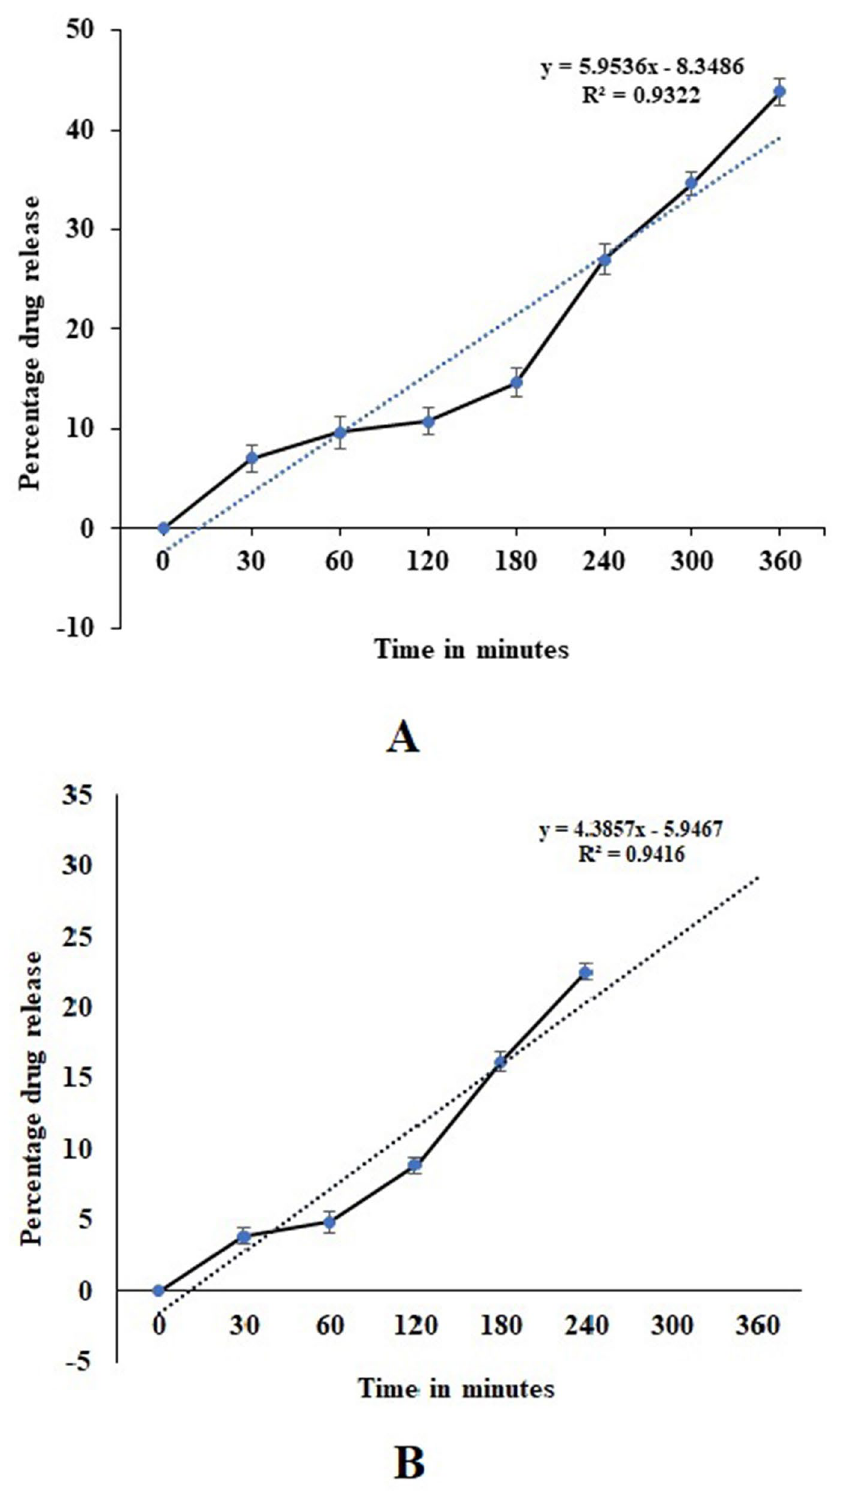
Figure 11. In vitro release profile study. ( A ) Release pattern of cisplatin from CCNP ( B ) Release pattern of cisplatin from